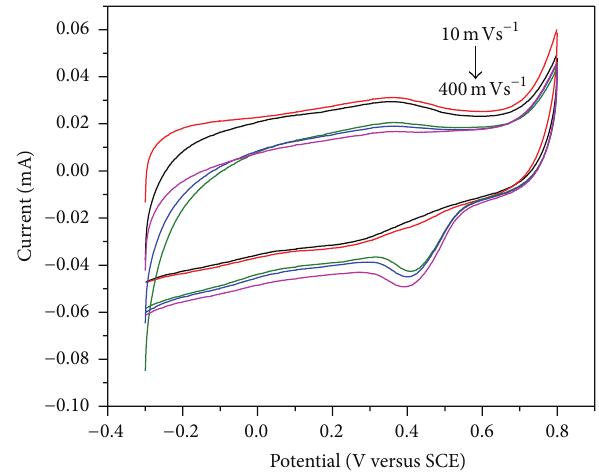
Figure 5: Voltammetric responses during the deposition of Au nanoparticlestochi-graphene/goldelectrodein0.1 MHCl(scanrate = 50 mVs −1 ).